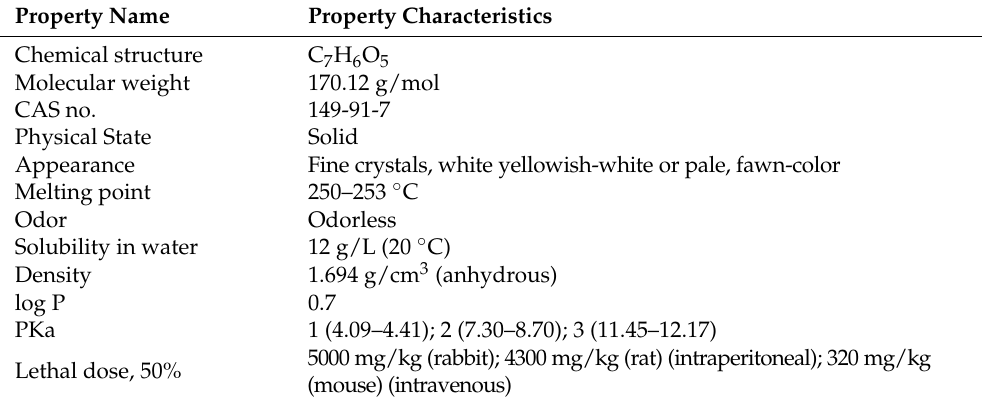
Table 1. The physical and chemical properties of gallic acid [17–20].